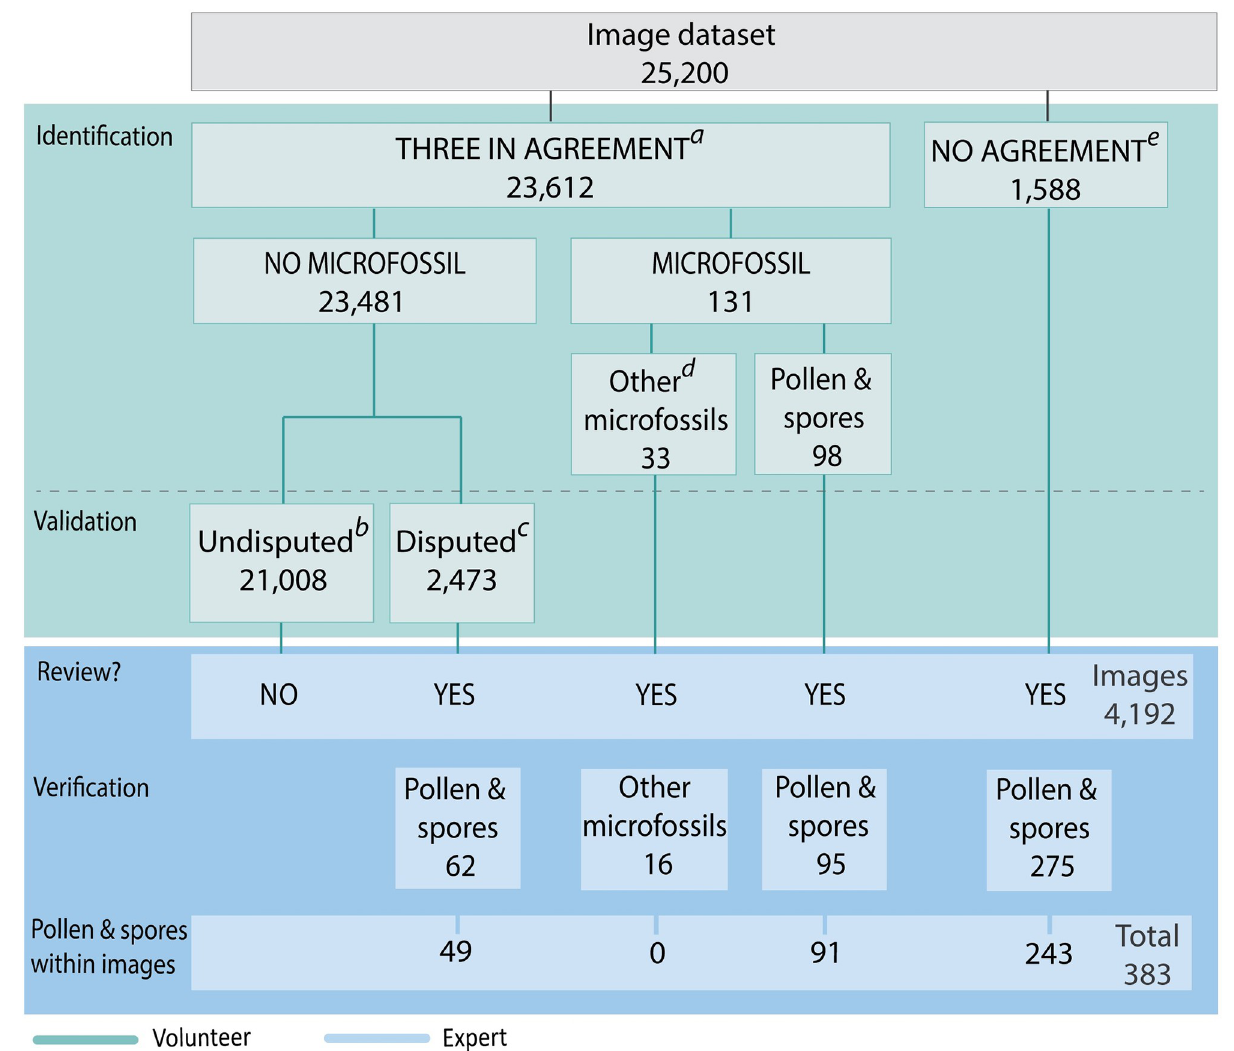
Fig 3. Flow chart outlining the identification and verification steps involved in the analysis of SEM images. Citizen scientist (volunteers) microfossil identification reduced the SEM image dataset from 25,200 to 4192. Experts reviewed the 4192 images and verified microfossils in 448 images. Accounting for image overlap, the final pollen and spore count in these verified images was 383, of which 300 specimens were identifiable. Key for superscript lettering: a —An ‘agreement’ was reached by a minimum of three volunteers on questions set out in the questionnaire template; this category was then subdivided into images indicated as having ‘no microfossil/s’ and images indicated as having ‘microfossil/s’. b —These images were undisputed (i.e., not disputed by a fourth volunteer). c —These images were disputed by an additional (fourth) volunteer and had to be reviewed by an expert. d —These images were identified by three volunteers as containing other microfossils, that are not pollen or spores. e —If ‘no agreement’ was reached by a minimum of three volunteers on questions set out in the questionnaire template, these images were automatically marked by the system to be